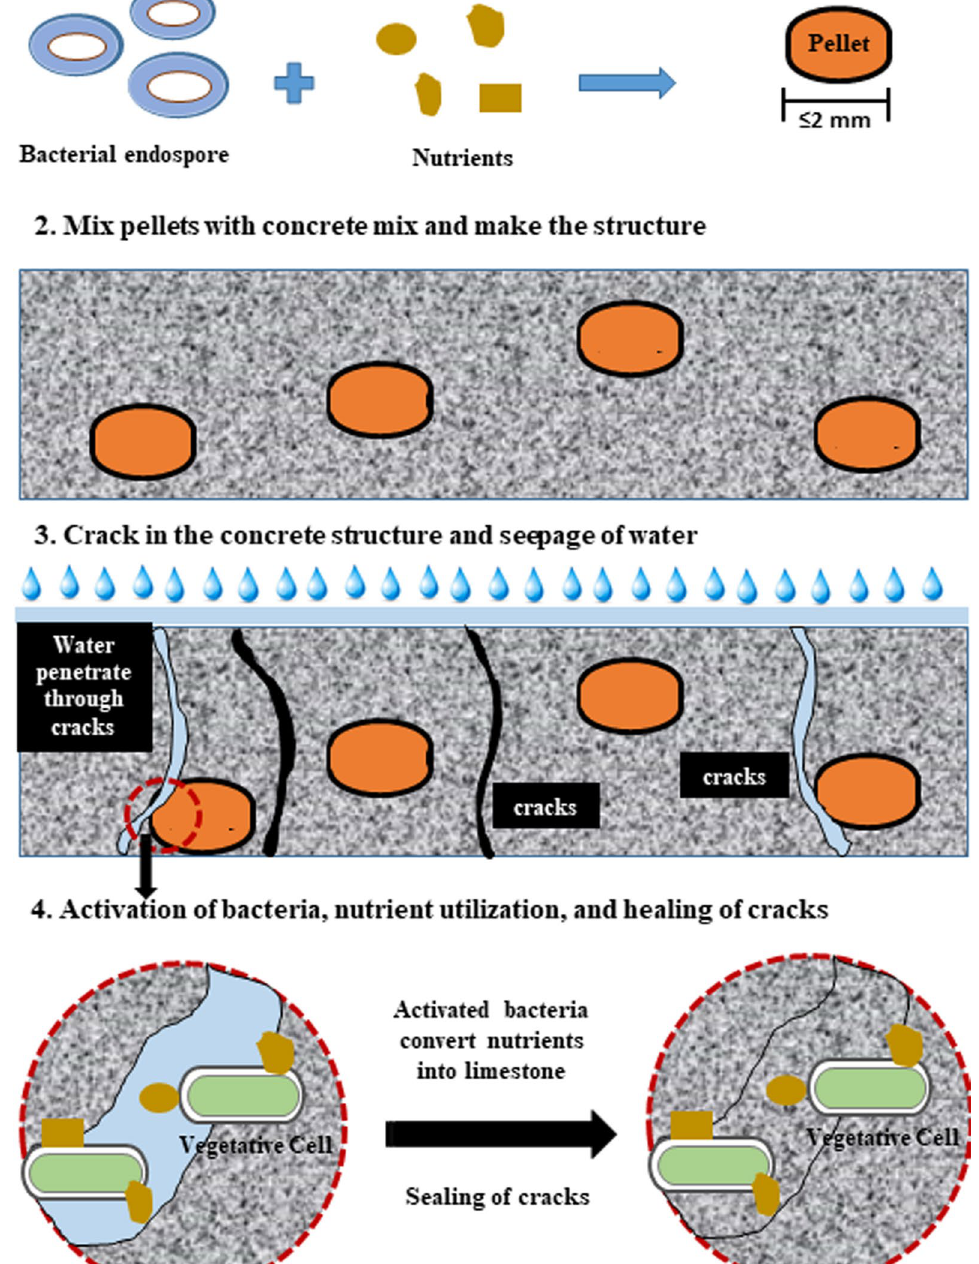
Fig. 1 Steps involved in Ureolysis, the most used and studied MICP pathway in the line of self-healing microbial